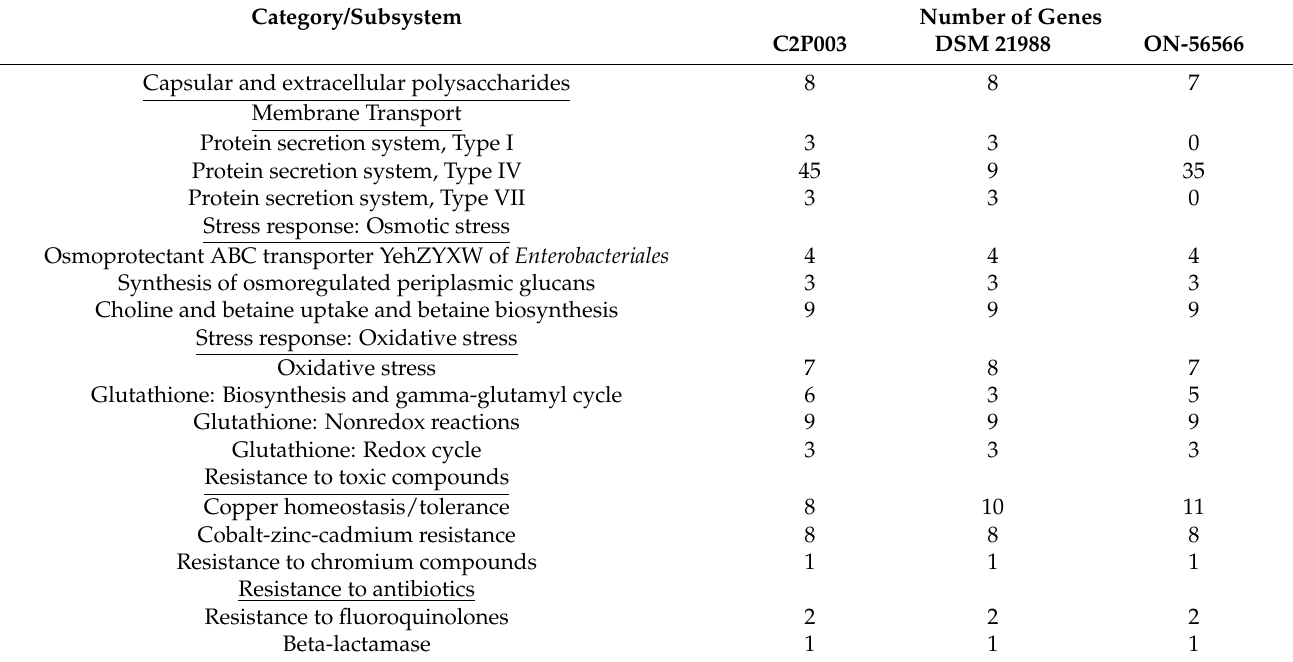
Table 2. Summary of protein-coding genes involved in host colonization and stress adaptation in the genome of A. altamirensis C2P003 and corresponding genes in the genomes of DSM 21988 and